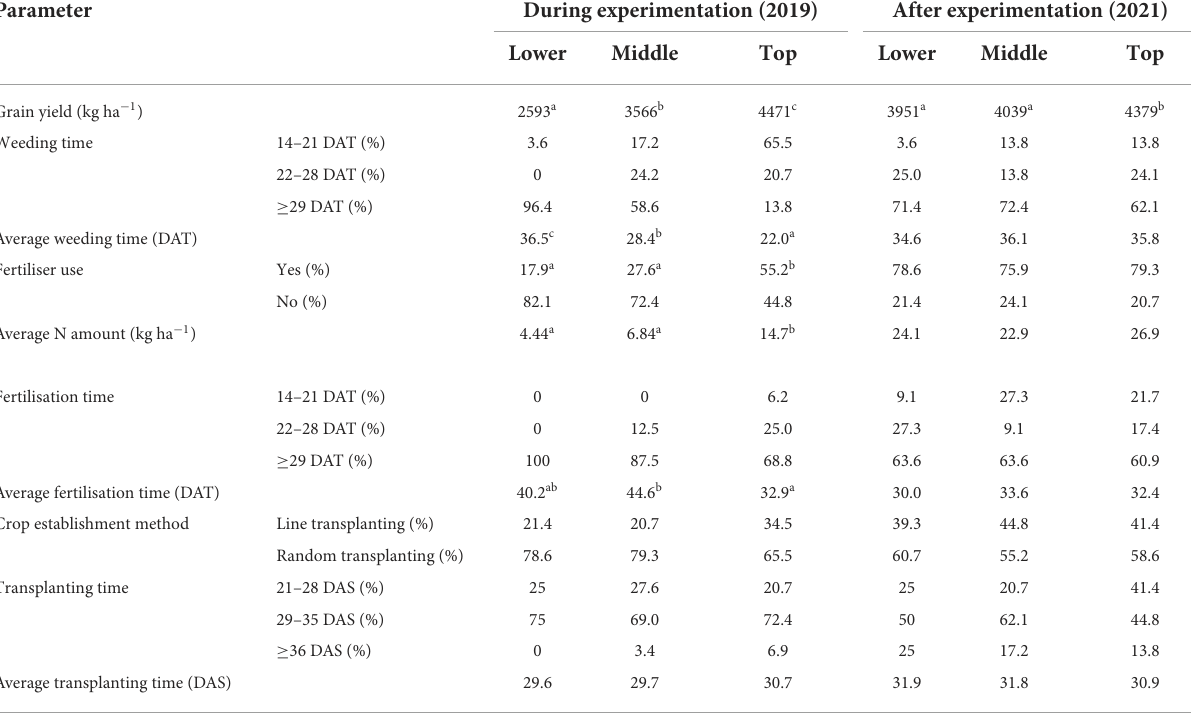
TABLE 3 Grain yield and management practices during (2019) and after (2021) joint experimentation separately for the same farmers with lower, middle and higher yields during joint experimentation in 2019. Parameter During experimentation (2019) After experimentation (2021) Lower Middle Top Lower Middle